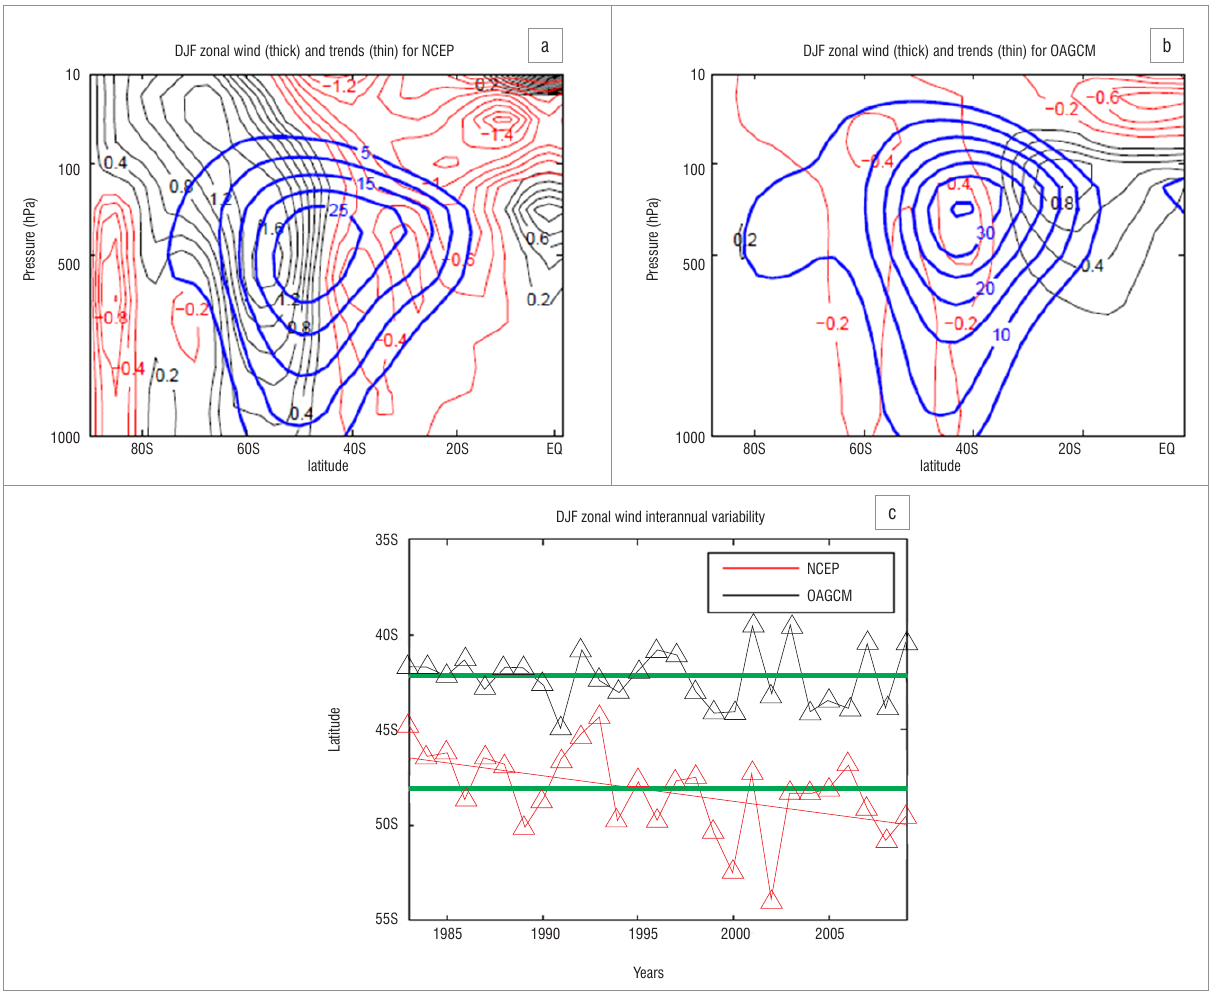
Figure 4: The eddy-driven jet (blue contours) with trends in the zonal winds superimposed for (a) NCEP and (b) OAGCM. Red contours represent negative and black represent positive trends in m/s/decade. The zonal mean isotachs and trends thereof are drawn in 5 m/s and 0.2 m/s/decade contour intervals, respectively. (c) Representation of the interannual variation with NCEP (red line) and OAGCM (black line) linear trends over the analysed period. The green line is the climatological position of the jet in both data